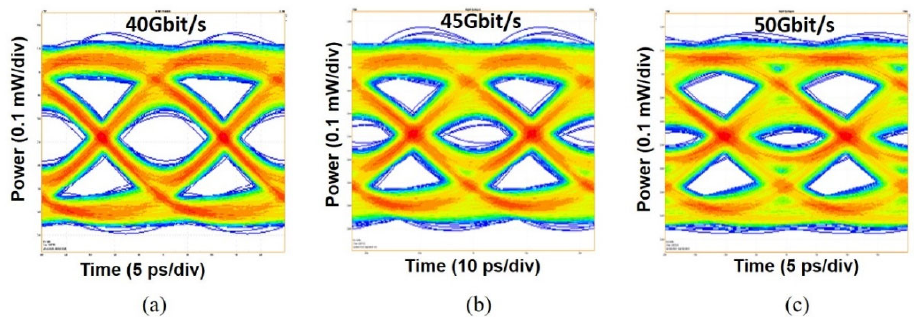
Figure 10. The microscope picture of the top mesa with ( a ) one aperture, ( b ) four apertures, and ( c ) seven apertures. ( d ) The microscope picture of the MAV with seven apertures. A number of holes are arranged in a symmetric hexagonal.